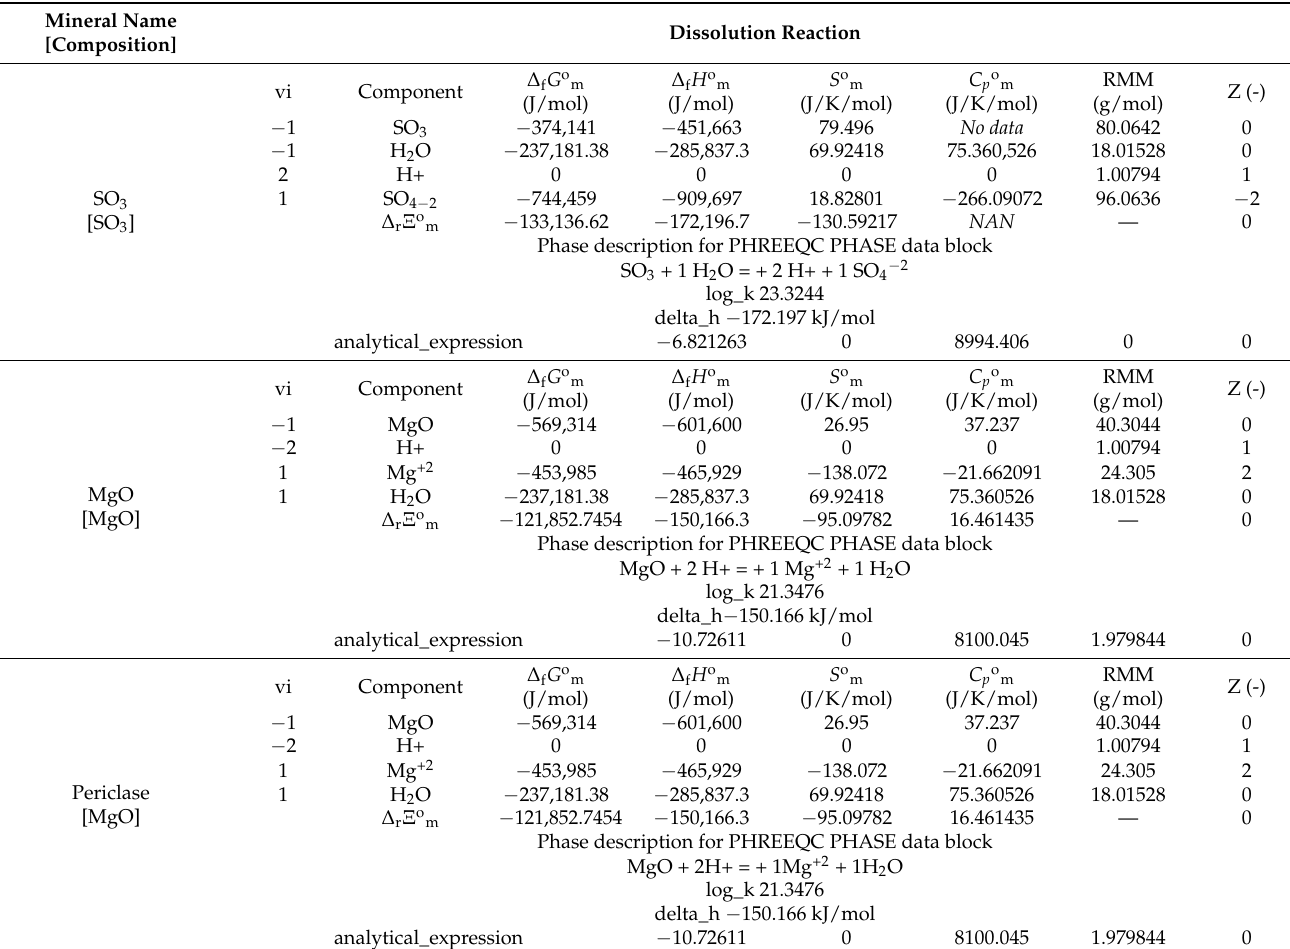
Table 3. Thermodynamic data to derive SO 3 , MgO and Periclase phases taken from